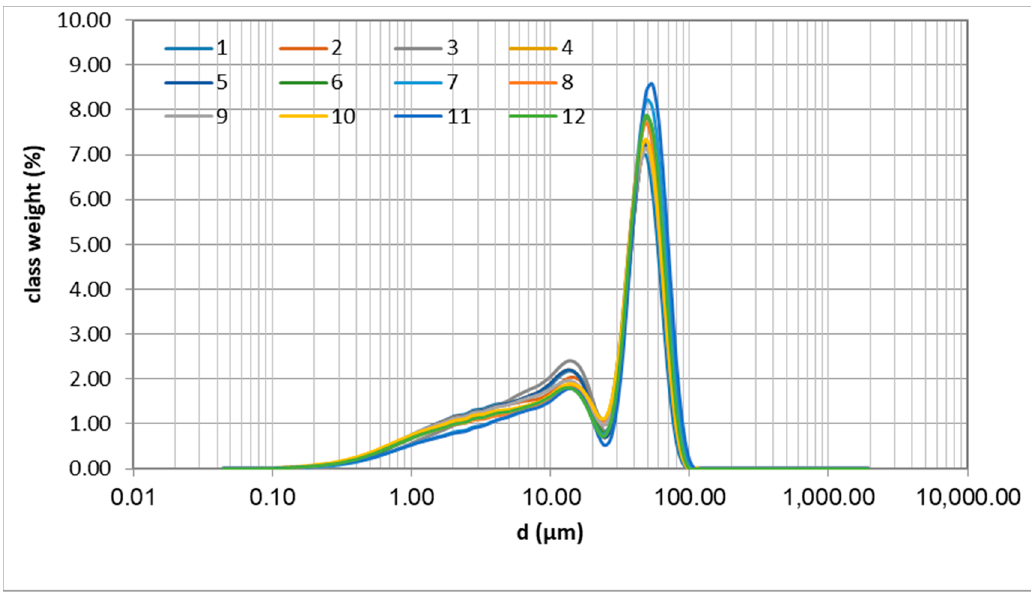
Figure A2. Particle size distribution (PSD) was analyzed by the laser diffractometer technique (ANALYSETTE 22 MicroTec Plus). Twelve aeolian samples were tested from all sites, one sample for each year of the study. 1–3 Shmarya, 4–6 Asaf, 7–9 Dorot and 10–12 Lachish.